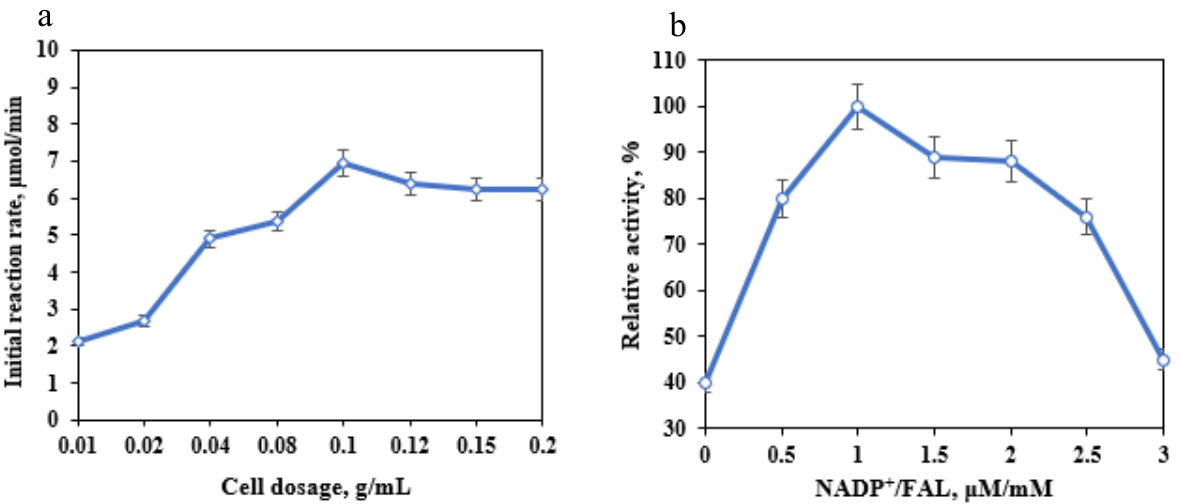
Figure 4. Effects of cell dosage ( a ) and NADP + dose ( b ) on FAL-reducing activity in ChCl:LA–water (30:70, v / v ).